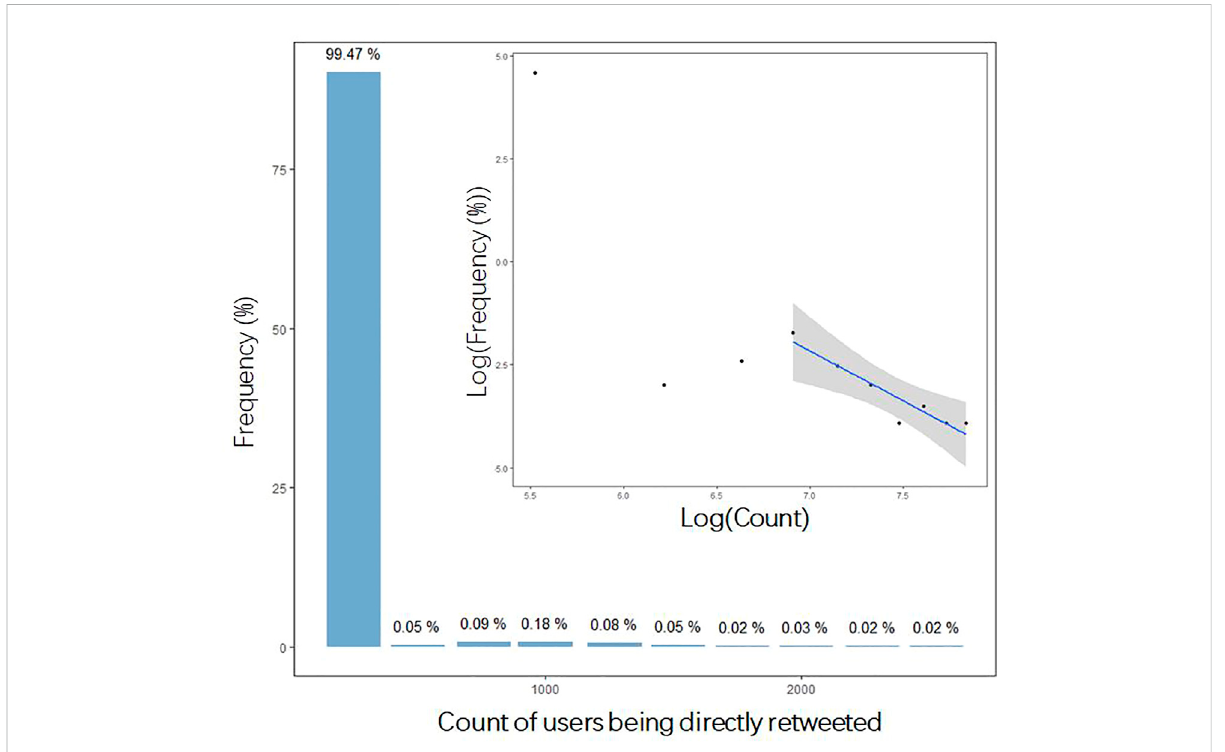
FIGURE 2 Distribution of the count of users being directly retweeted. The inserted is the distribution in log-log scale. The fi tted line is log(frequency) = 6.256 − 0.3664*log(count), with R 2 = 0.8853.